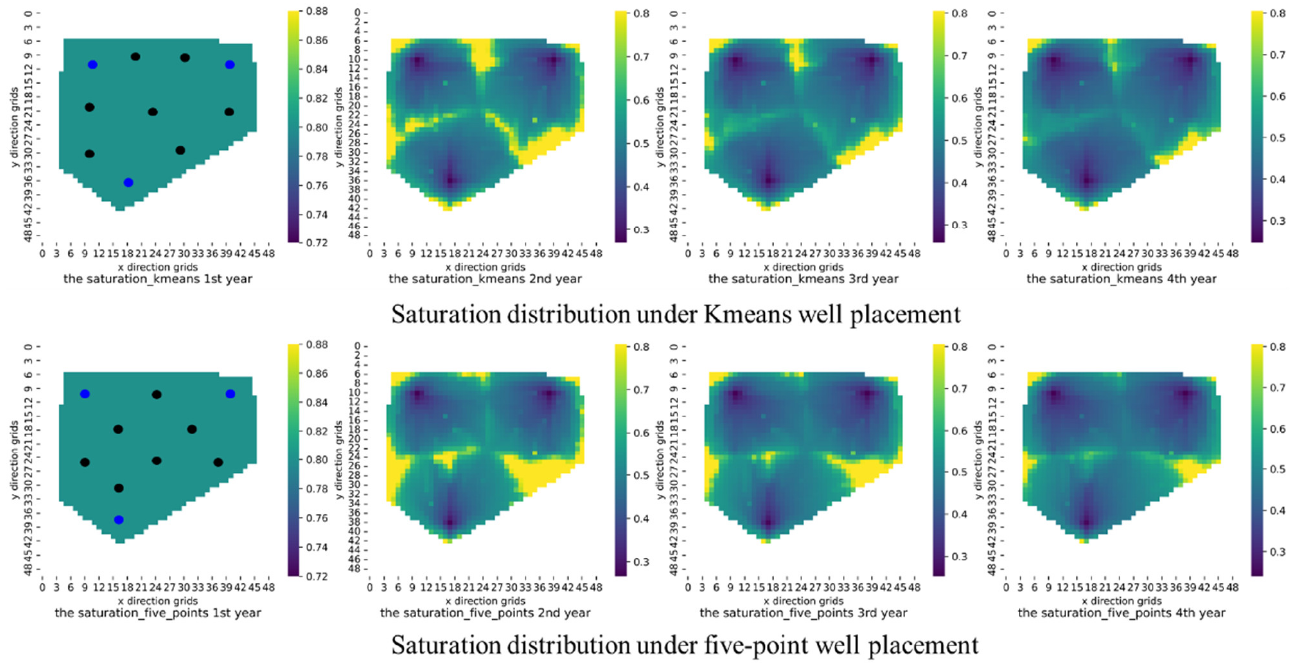
Figure 12. Comparison of oil saturation in multiple steps from our method and the five-point method.